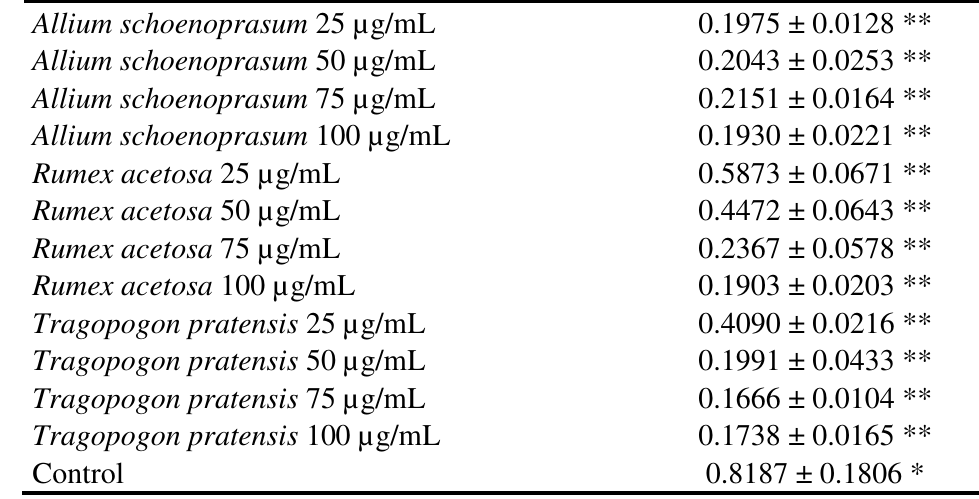
Table 2. Antiproliferation effect of different concentration of herb flowers’ phenolic compounds on HaCaT cells quantified by a MTT assay (Average absorbance ±